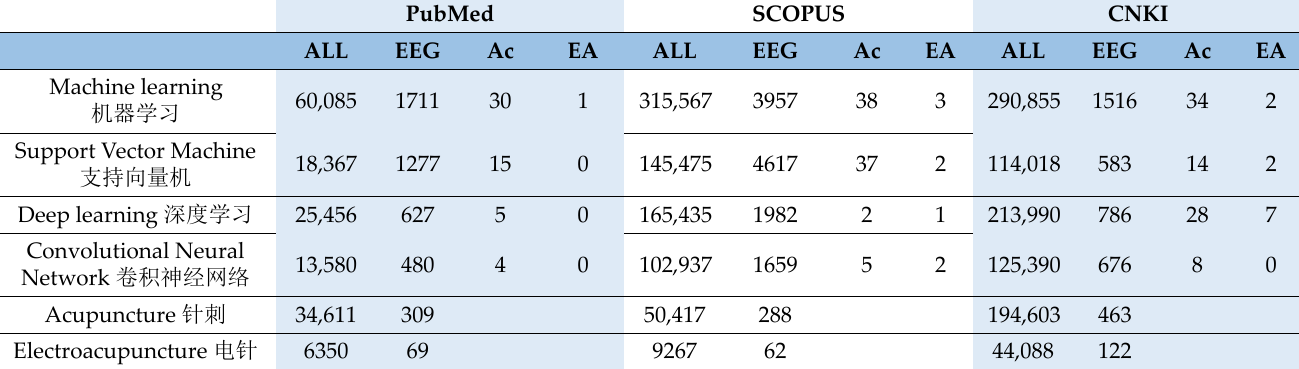
Table 3. Numbers of studies located on 5 December 2021 in PubMed, SCOPUS and CNKI on